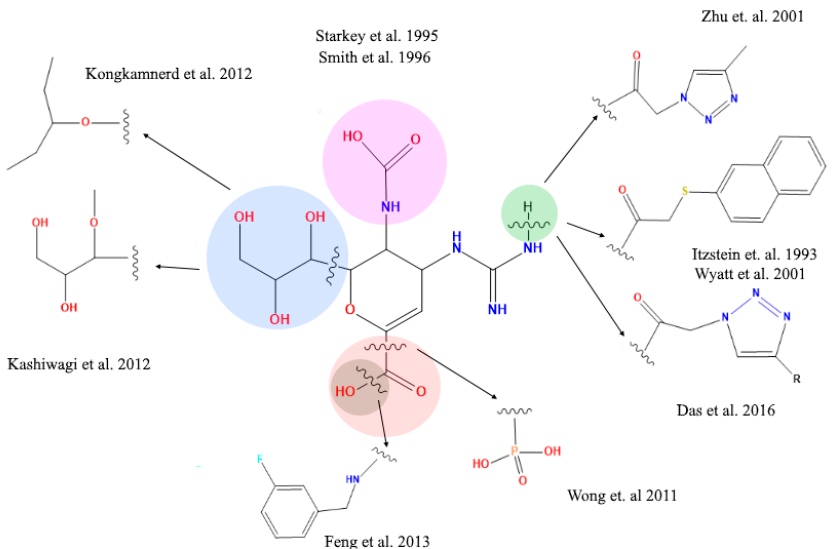
Figure 5. Structural modifications of zanamivir molecule reported in the literature. The amide and carboxyl groups are essential for the interaction with the arginine residues at the active site of the viral neuraminidase target protein.